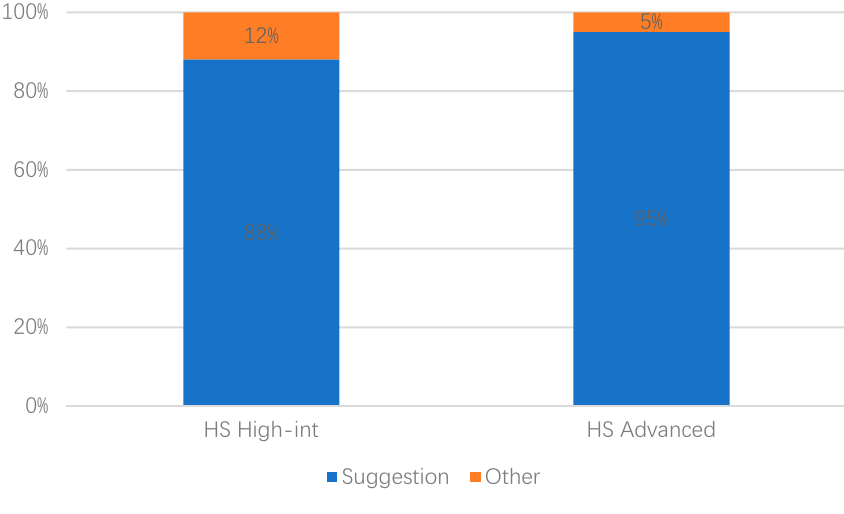
Figure 2. Percentages of heritage speakers who translate the suggestion SFP ba sentence into an English suggestion and heritage speakers who translate it into other types of sentences in English.